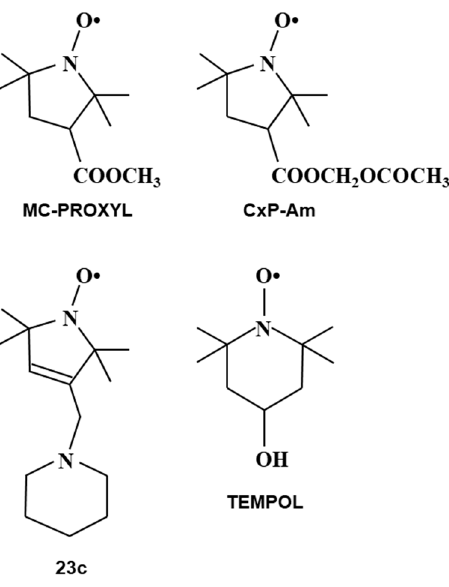
Figure 12. Chemical structures of membrane permeable nitroxyl radical contrast agents.